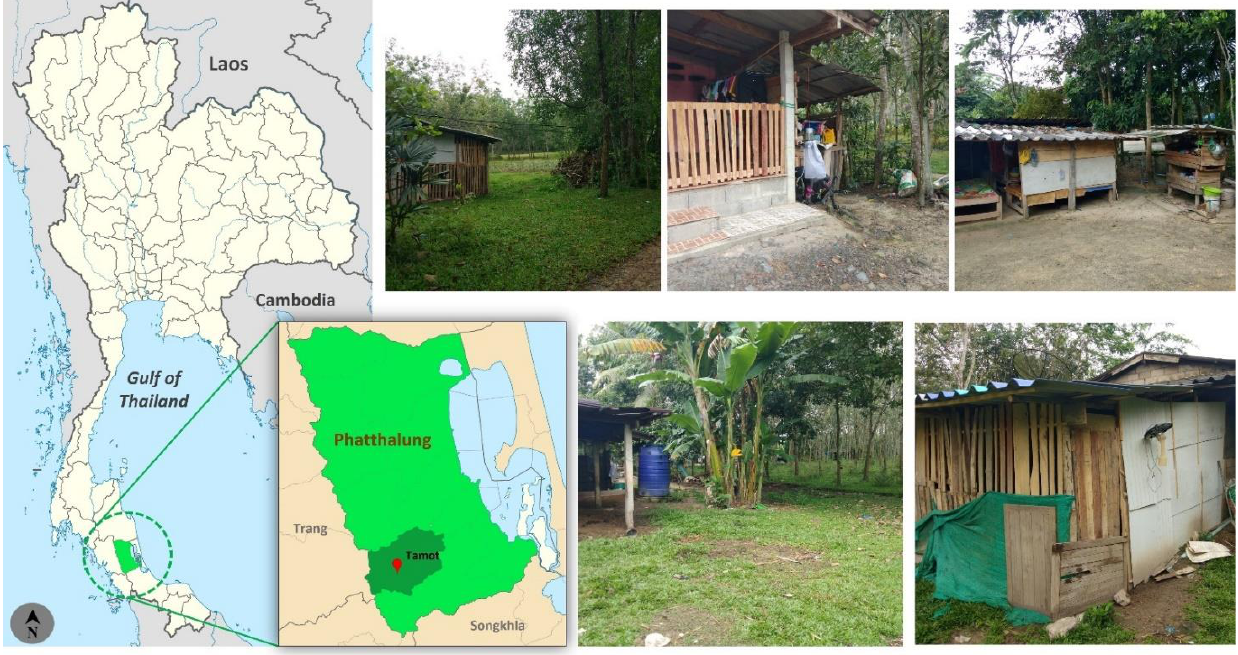
Figure 1. Map of Thailand (https://en.wikipedia.org/wiki/Phatthalung_province; accessed on 27 June 2022) and location of study, including the photographs of trap sites in Phatthalung province, southern Thailand. The photos were taken by Sakone Sunantaraporn, the first author.